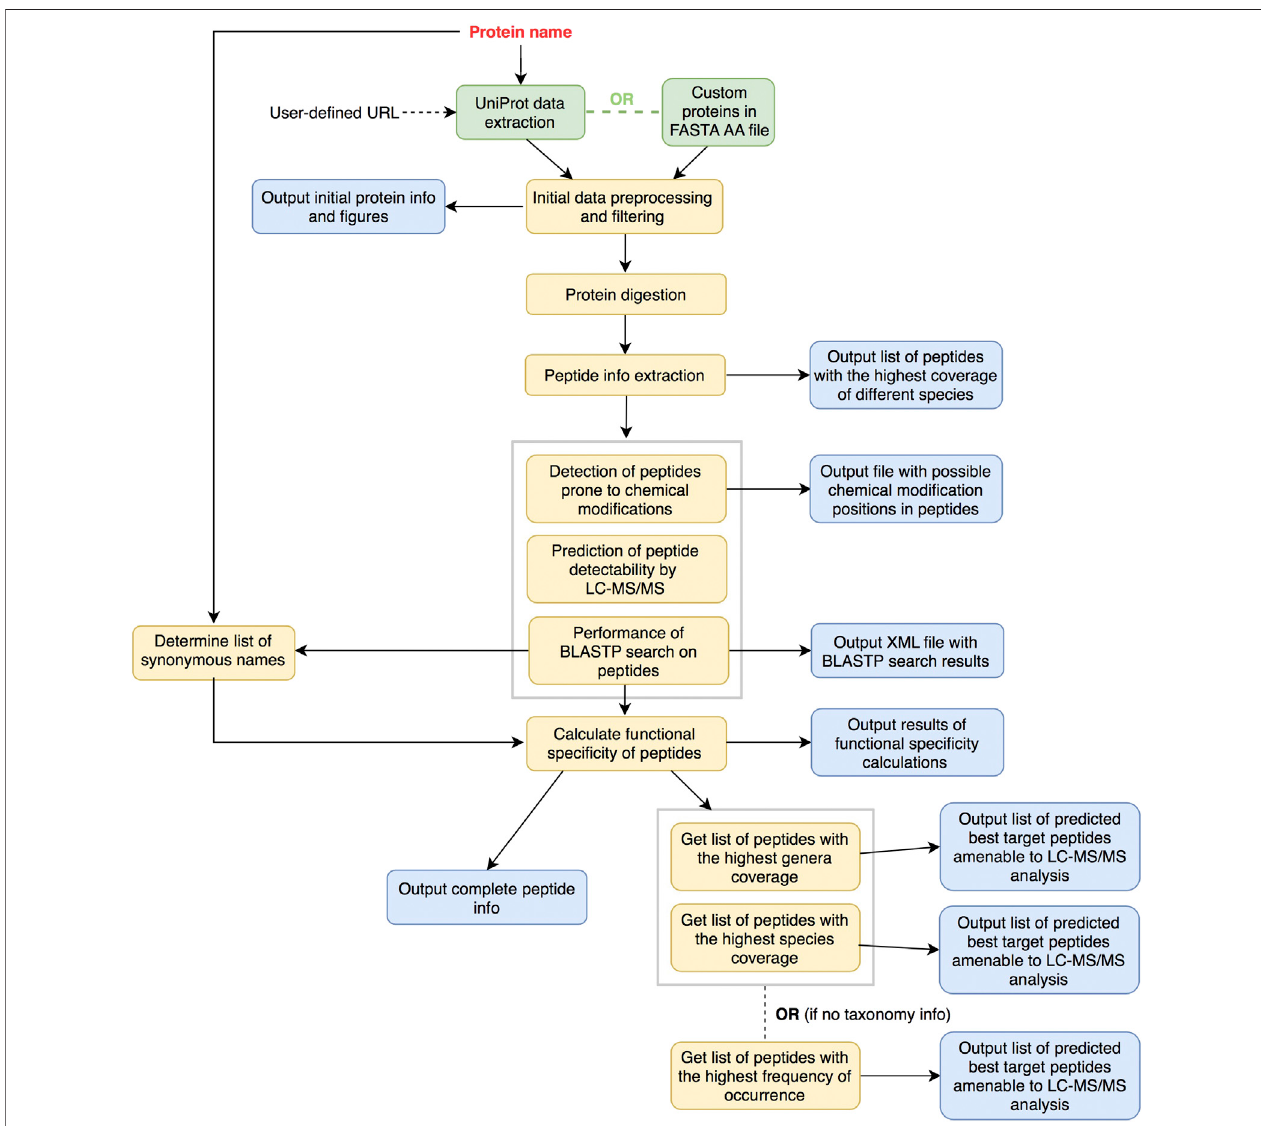
FIGURE1| Overviewofgeneralpeptidepredictionwork fl owasimplemented inPepMANDIS. InputsequencesareeithergatheredfromUniProtDBorprovidedas a fi le in FASTA amino acid format. They are consequently digested proteolytically in silico and subjected to the next steps of data processing.